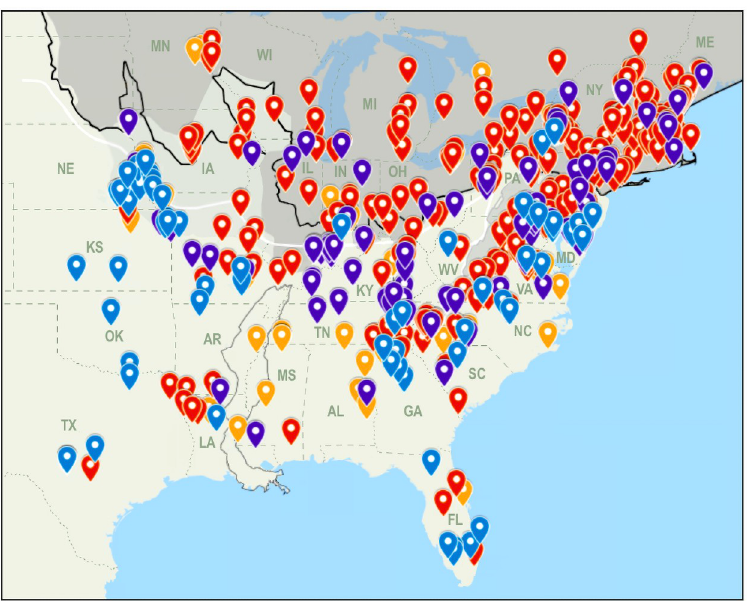
Fig 8. Mapped locations of all analyzed singers displayed concurrently with glacial environment. Song type sympatry and former glacial conditions. Pre-Illinoian glacial maximum is represented with a light gray screen, Illinoian glacial maximum and high-altitude periglacial permafrost are represented by dark gray screens, the Last Glacial Maximum boundary is indicated by a black line and accompanying permafrost boundary by a white line, and a gray outline represents the Mississippi Embayment.